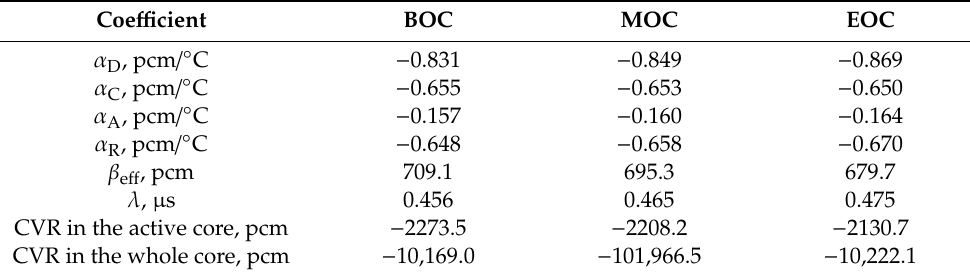
Table 5. Reactivity feedback coe ffi cients and kinetics parameters.